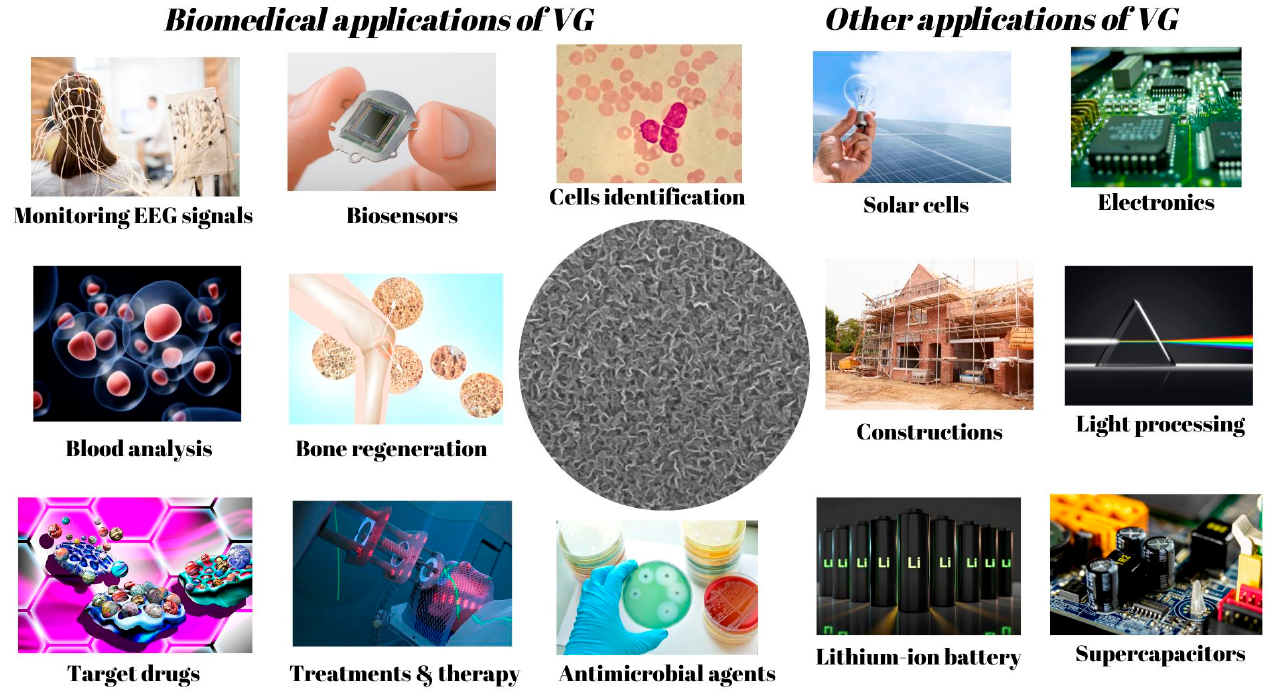
Figure 6. Examples of applications in which VG could be successfully used.